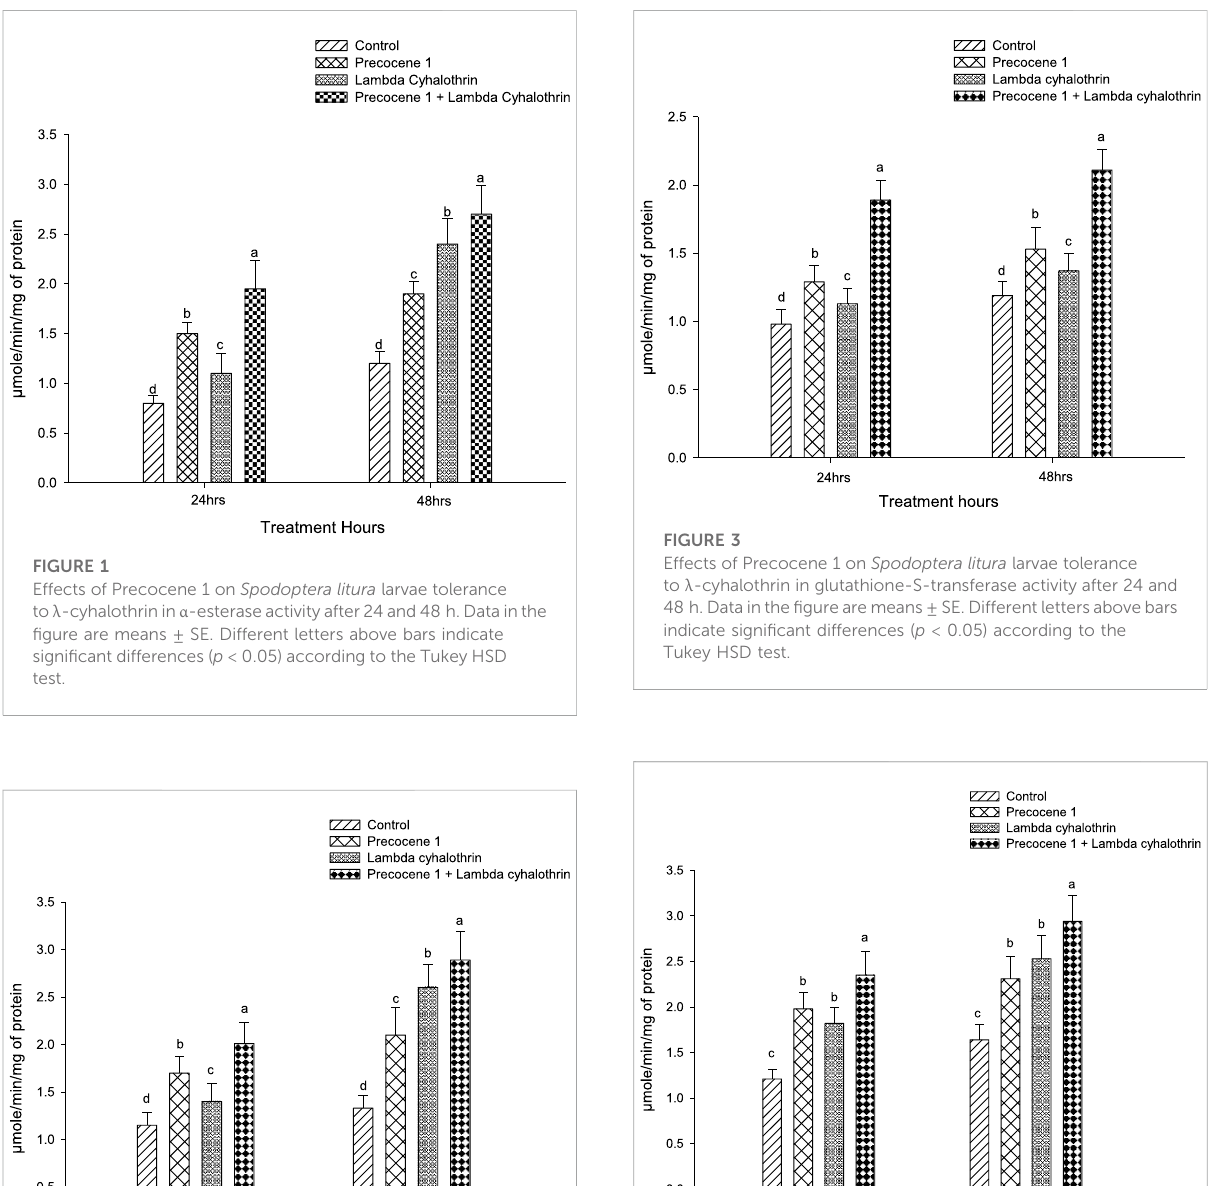
FIGURE 4 Effects of Precocene 1 on Spodoptera litura larvae tolerance to λ -cyhalothrin in cytochrome P450 activity after 24 and 48 h. Data in the fi gure are means ± SE. Different letters above bars indicate signi fi cant differences ( p < 0.05) according to the Tukey HSD